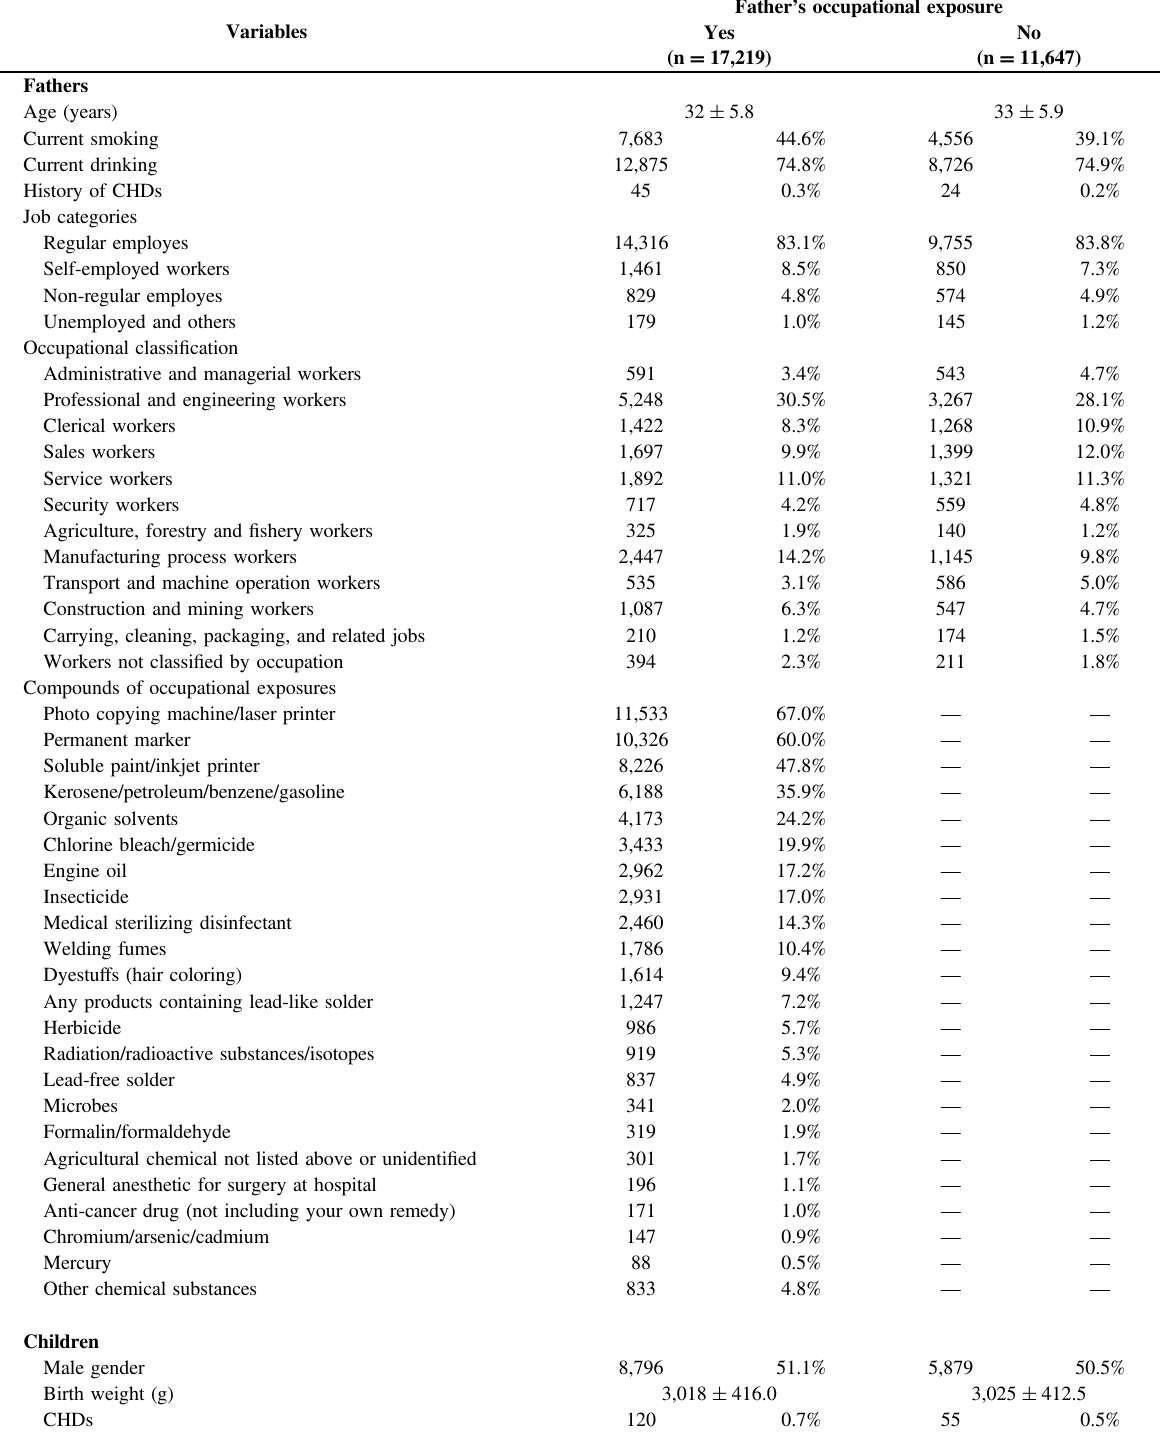
Table 1 Characteristics of children ’ s fathers and children according to the father ’ s occupational